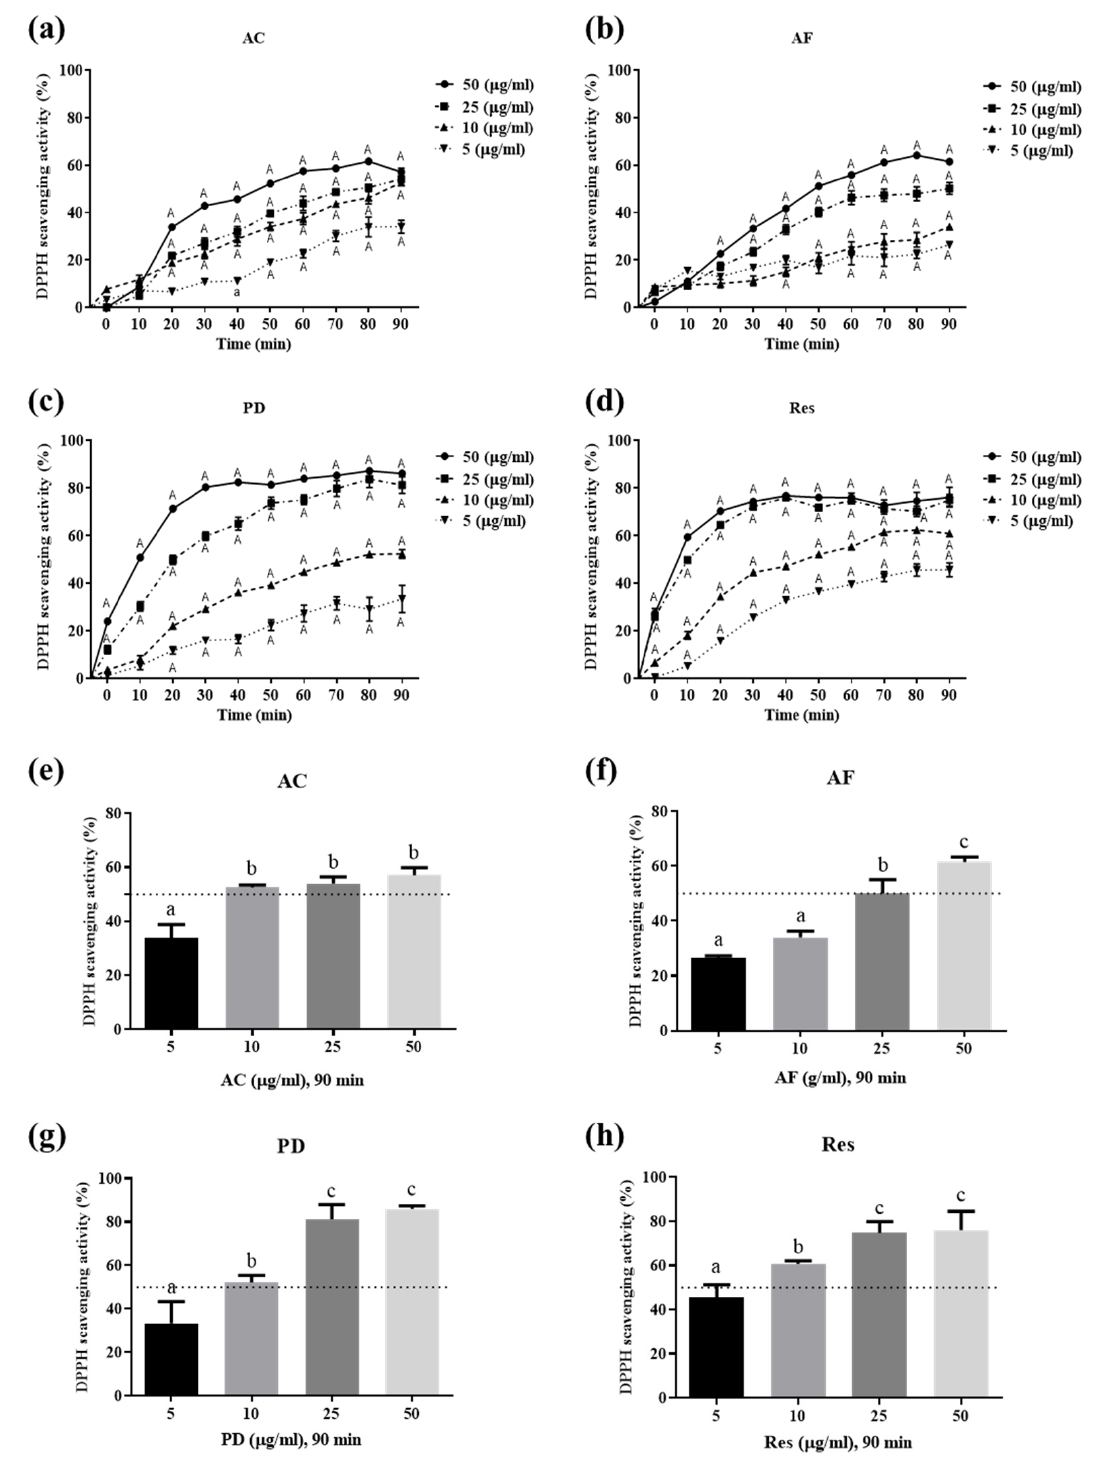
Figure 2. Effects of AC, AF, Res, and PD on the scavenging ability of DPPH • free radicals. ( a , e ) AC; ( b , f ) AF; ( c , g ) PD; and ( d , h ) Res reacted with DPPH • radicals for various times, and a SpectraMax i3 microplate reader detected the absorbance values at 520 nm. The results are presented as the mean ± SD from 4 experiments and analyzed ( a – d ) using two-way ANOVA followed by Tukey’s mul- tiple comparisons post hoc test. a p < 0.05, A p < 0.01, compared with the untreated group at the same concentration of the drugs; ( e – h ) using one-way ANOVA followed by Tukey’s multiple comparisons post hoc test. p < 0.05, and different letters represent significant differences between